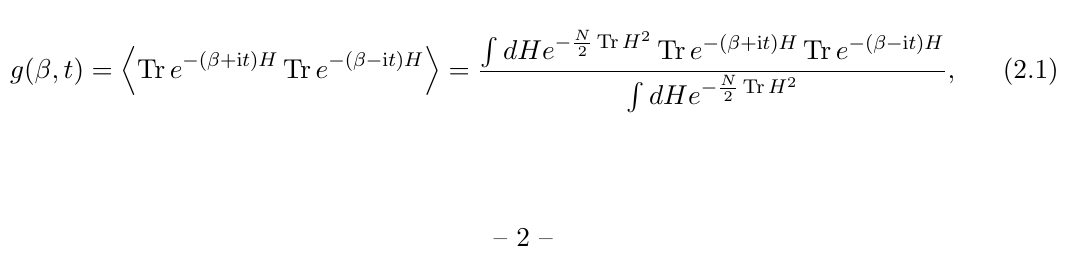
integrating over the whole range of eigenvalue distribution, the actual ramp is not a